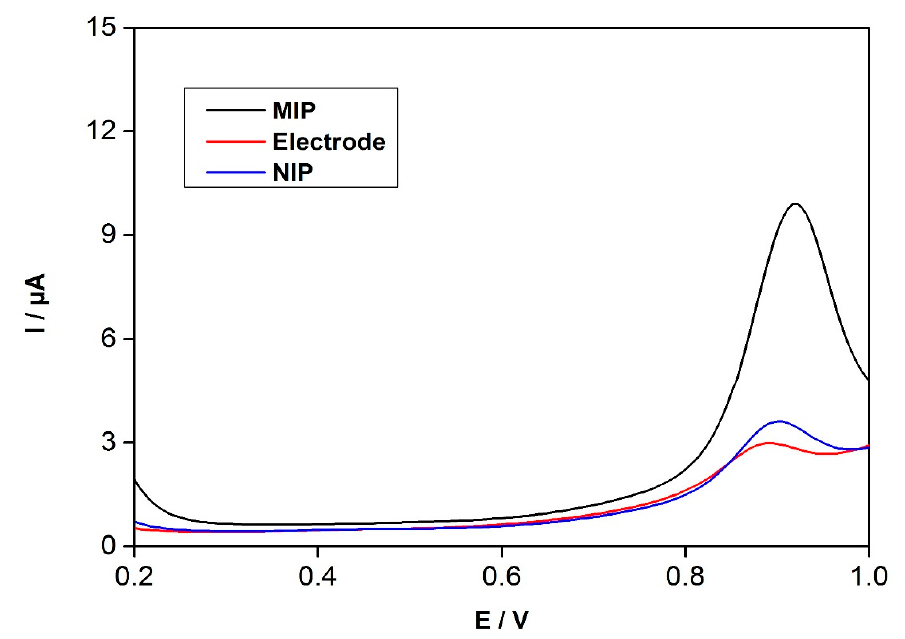
Figure 6. Square wave voltammetry (SWV) to modified gold electrodes in the presence of a sample of enrofloxacin at 1 mM in a pH 3 buffer solution.